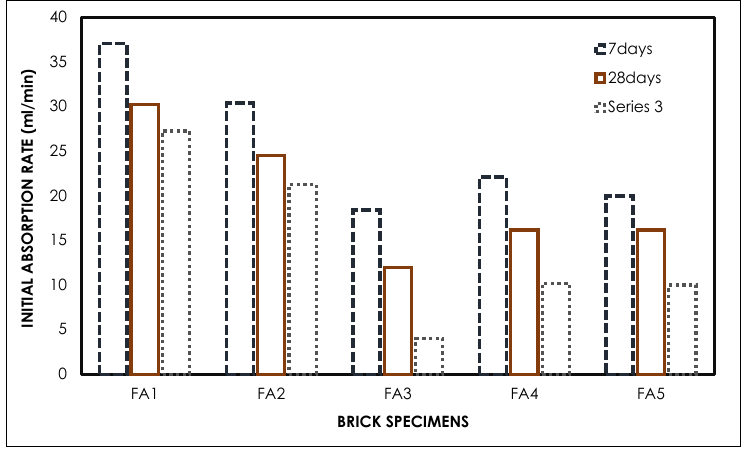
Figure 6: Initial absorption rate of the bricks specimens